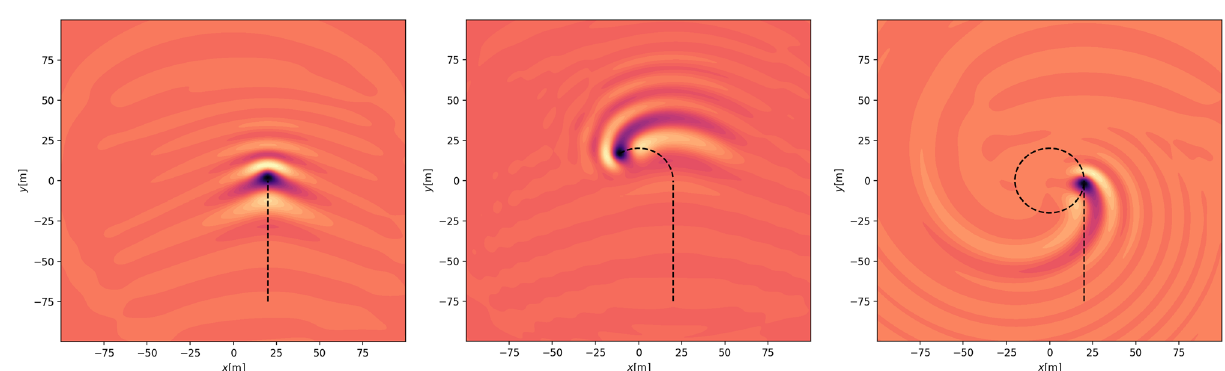
Figure 2. Strain in ice due to wave excited by moving load. In this case, the depth is H 0.1 m, E 4.2 10 9 N/m 2 , and otherwise as in Fig. 1. The load is 100 kg, moving at a speed parameters are h = = × of 25 km/h. These values are the same is in 27 .